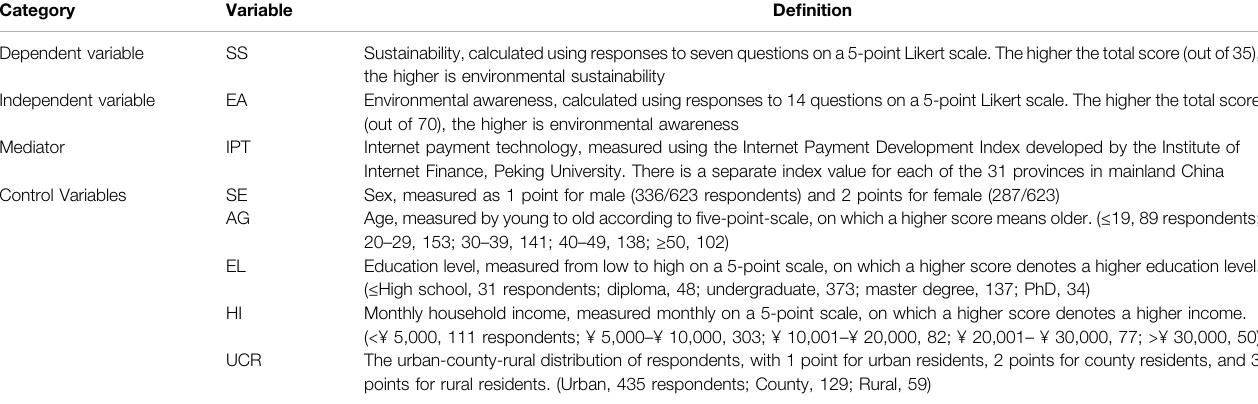
TABLE 1 | Variable de fi nitions.